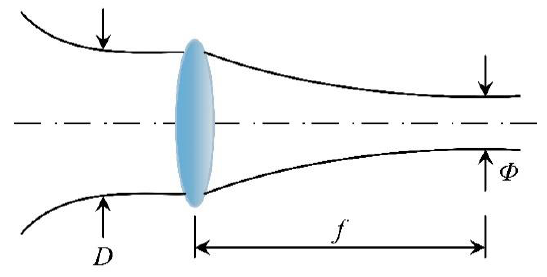
Figure 1. Schematic diagram of laser beam.